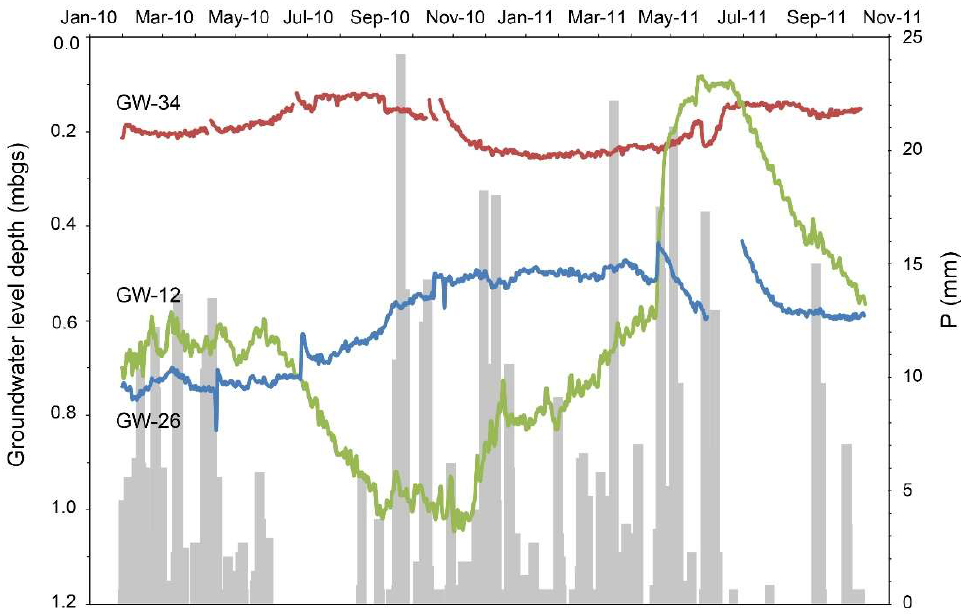
Figure 2. Groundwater-level evolution in the piezometers GW-12, GW-26, and GW-34 for the period February 2010–October 2011. See location in Figure 1. Bars indicate mean monthly precipitation (mm) values. Mbgs: meters below ground surface (adapted from [18]).